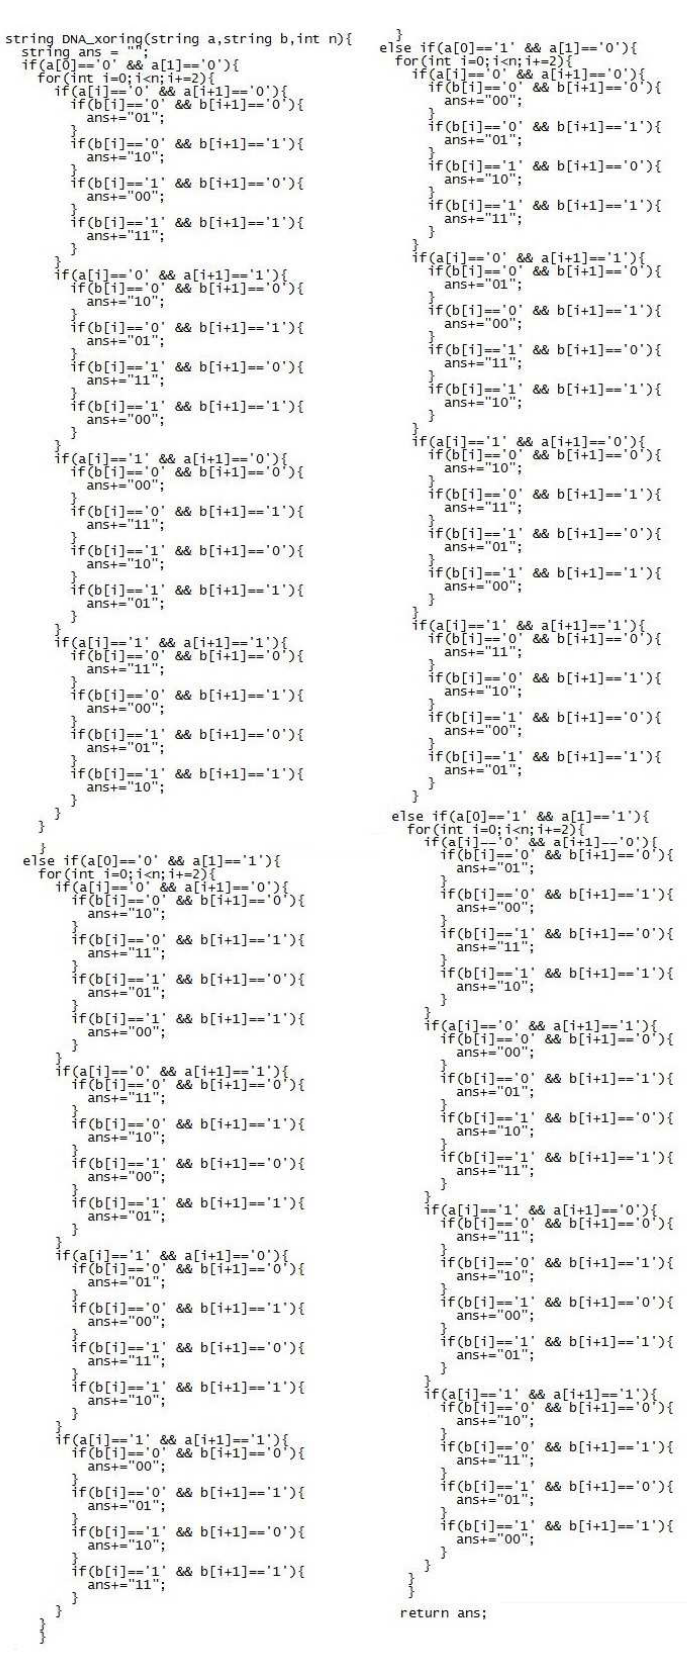
Figure A4. DNA XOR rules.